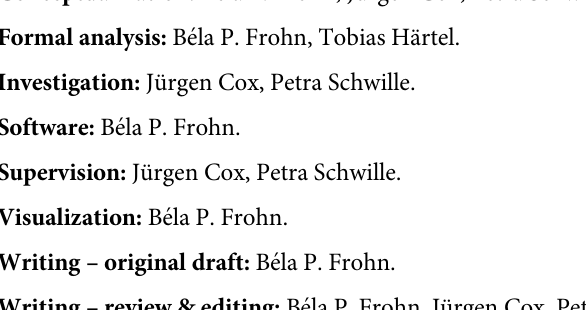
S1 Table. Domain locations of the investigated proteins. S2 Table. Protein and gene data of the investigated